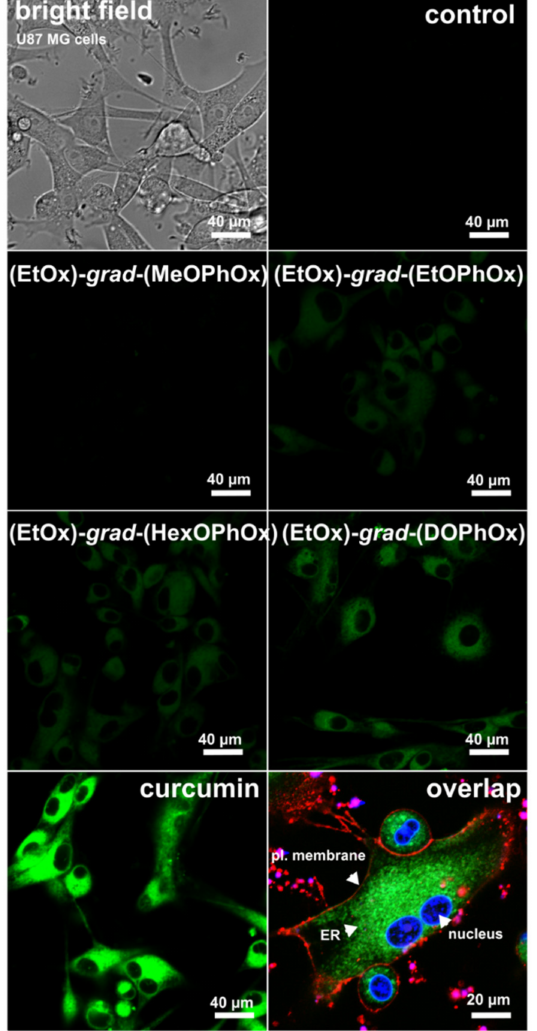
Figure 5. Distribution of curcumin in U87 MG cells detected by confocal fluorescence microscopy. Cells were incubated for 1 h with curcumin and curcumin loaded in polymeric NPs (green fluores- cence). Illustrative image of subcellular distribution of nucleus (blue), endoplasmic reticulum (green) and plasma membrane (red) is demonstrated in overlapped image (lower